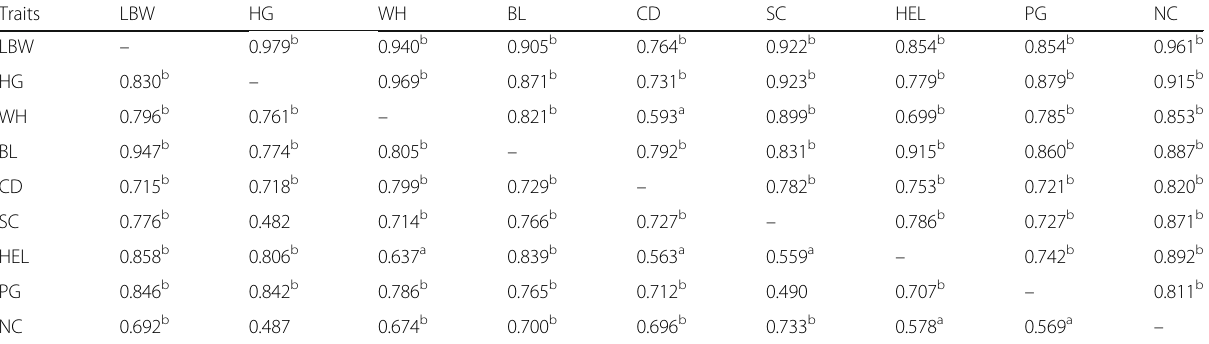
Table 2 Bivariate correlations among morphological traits and LBW of male (above diagonal) and female (below diagonal) Shami goats Traits